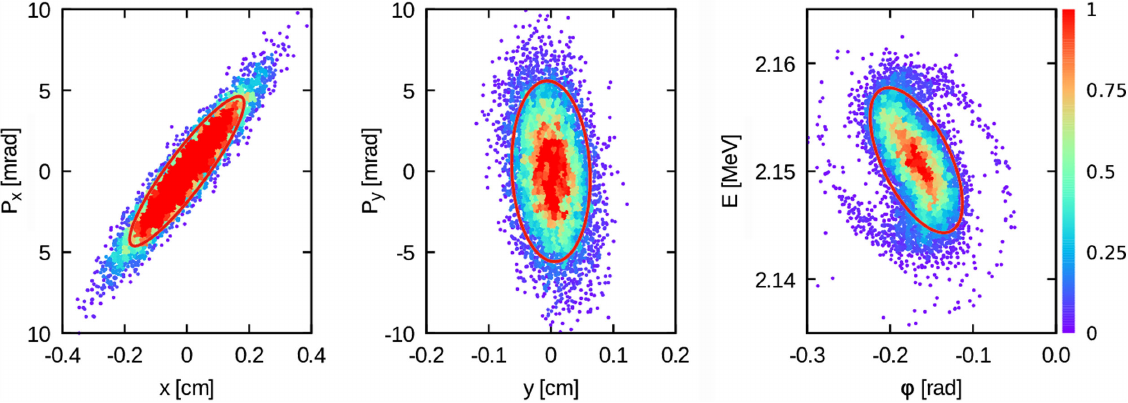
FIG. 6. PARMTEQ normalized particle density distribution compared to TRANSOPTR ellipse of area 4 πϵ containment for Gaussian distributed beam. Profiles for x - P of the vanes. Input longitudinal emittance has been tripled with respect to that used in Fig. 4.